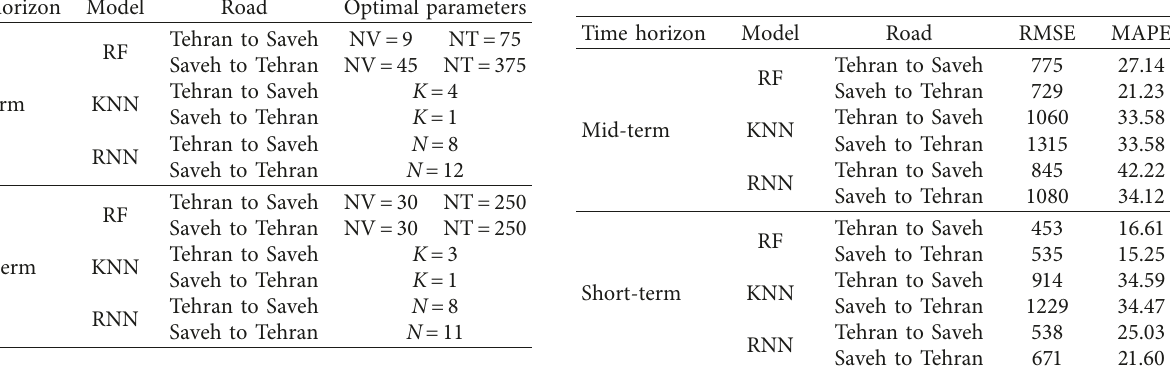
Table 4: Error metrics for the final